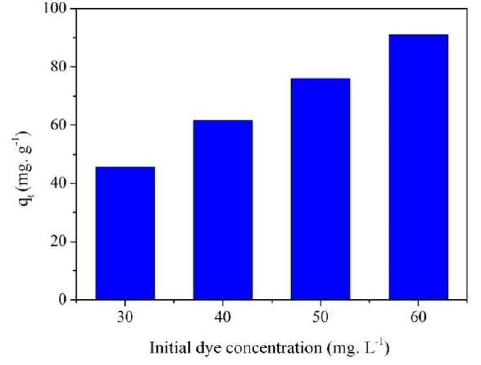
Figure 3. Effect of initial dye concentration on MB adsorption onto MPPL.